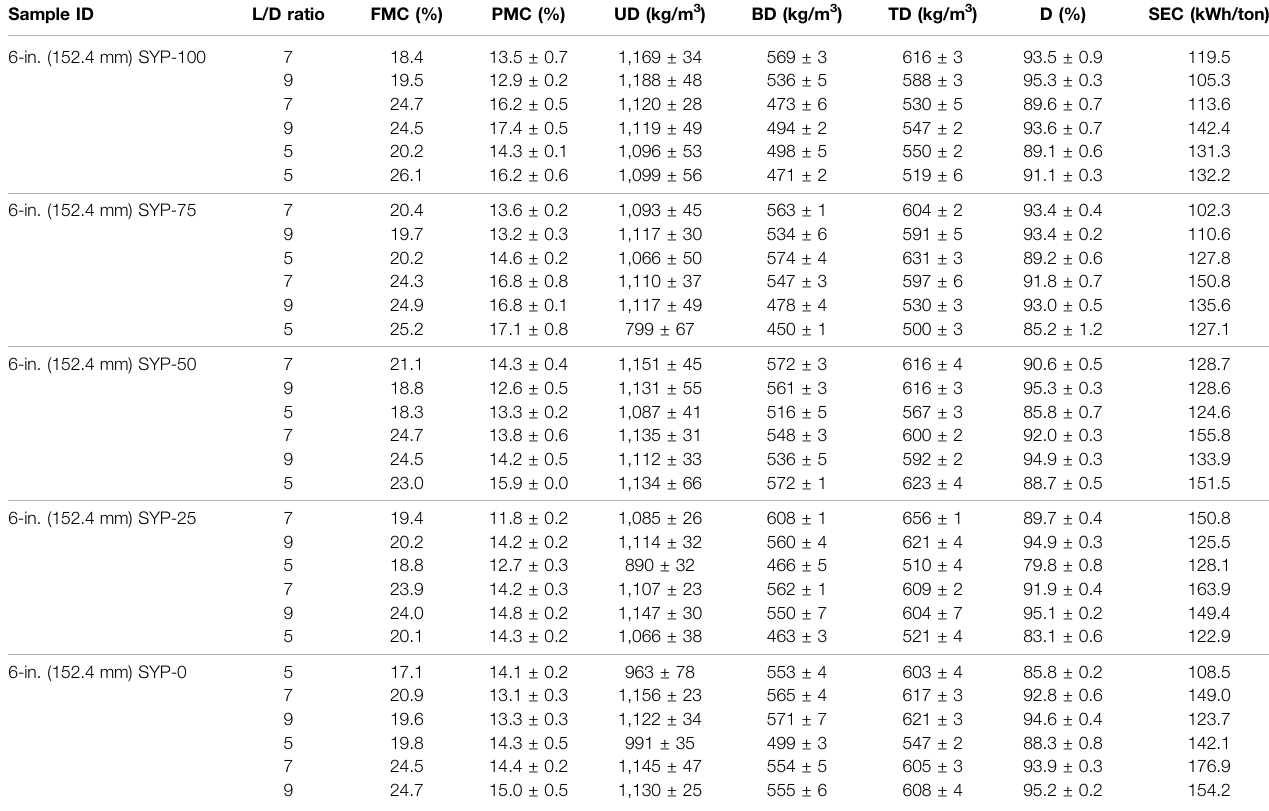
TABLE 3 | Average physical properties of high-moisture pellets produced immediately after pelleting during preliminary tests. Sample